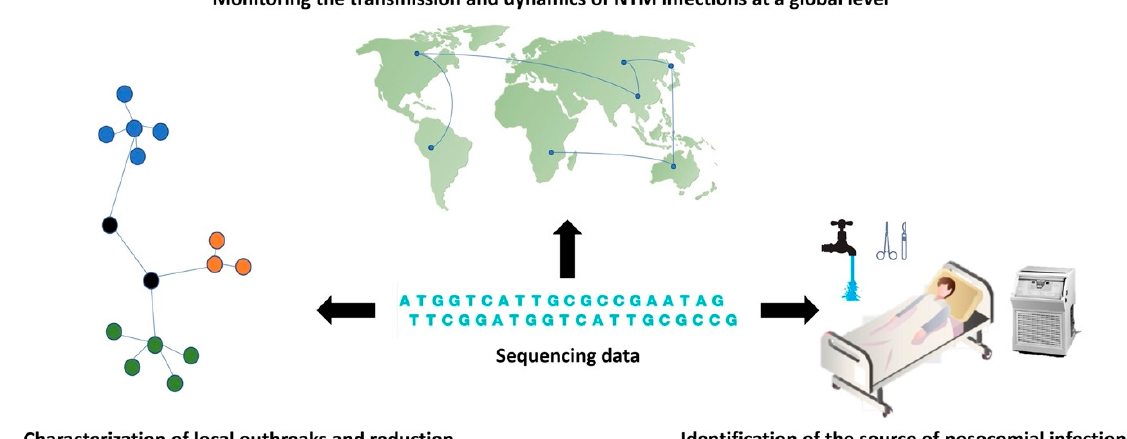
Figure 2. The contribution of WGS in the molecular epidemiology of NTM infections. Sequencing data can be used to describe the global spread and dynamics of NTM infections, to characterize local outbreaks, and also to identify sources of infection in hospital settings.